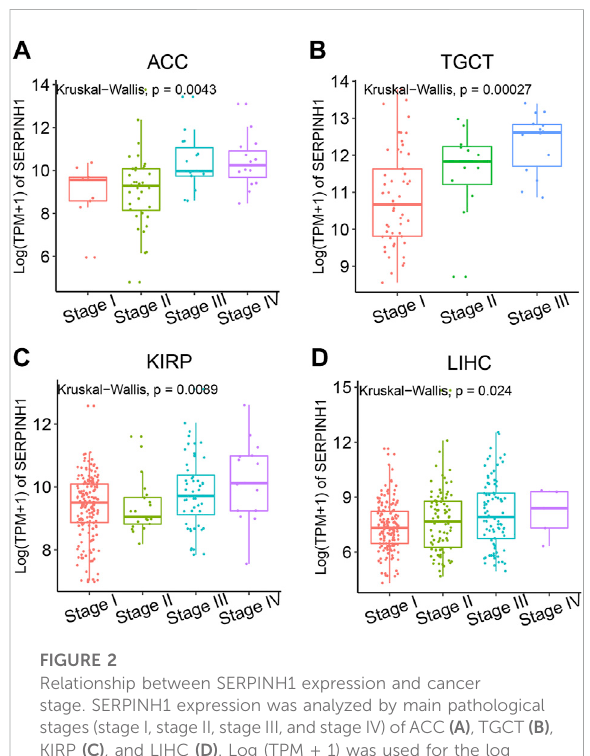
FIGURE 2 Relationship between SERPINH1 expression and cancer stage. SERPINH1 expression was analyzed by main pathological stages (stage I,stageII, stageIII,and stageIV) ofACC (A) ,TGCT (B) , KIRP (C) , and LIHC (D) . Log (TPM + 1) was used for the log